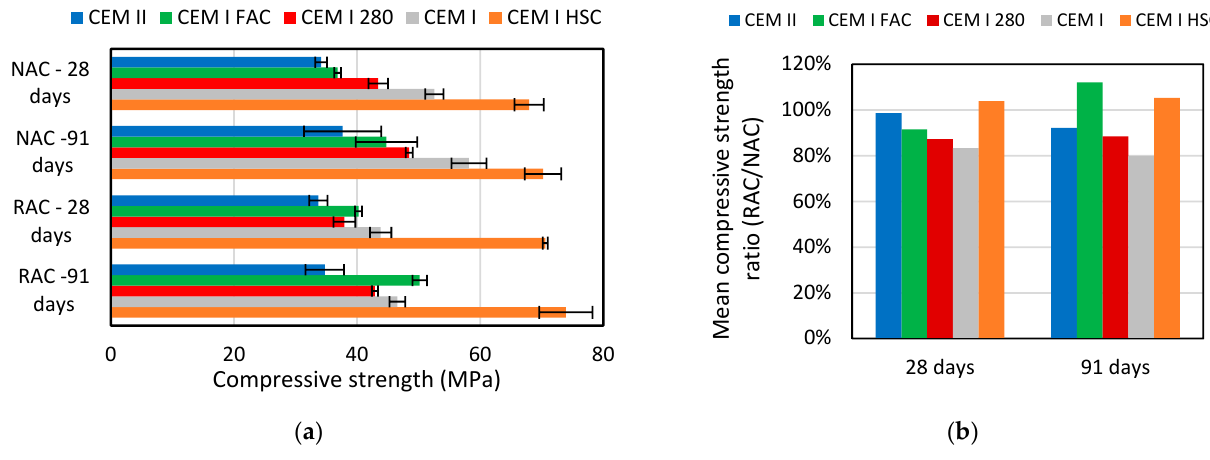
Figure 2. Compressive strength: ( a ) Compressive strength of each mix; ( b ) Ratio of the mean compressive strength (RAC/NAC) of each composition.